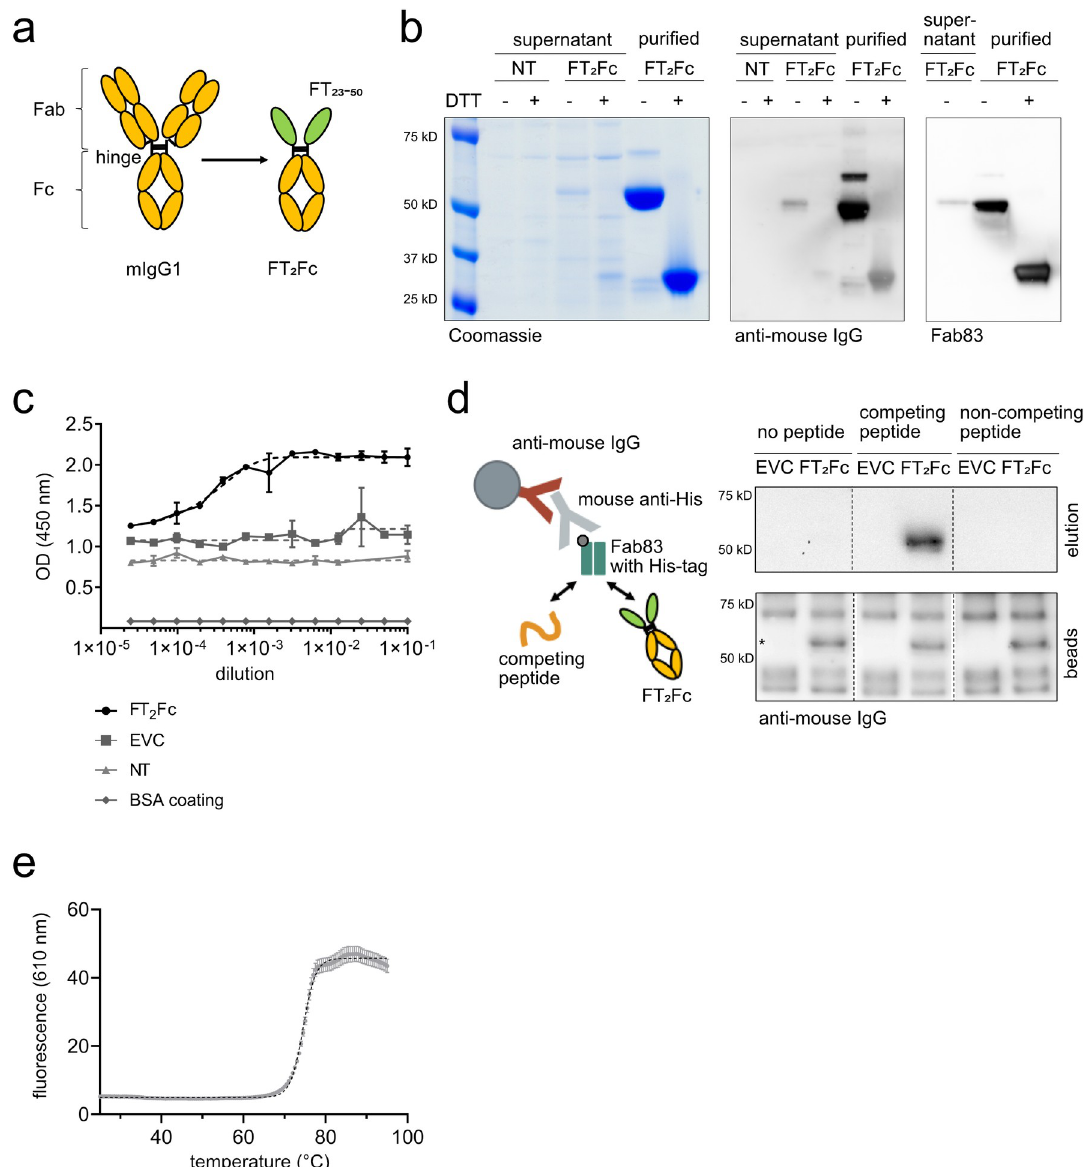
Fig 1. Characterization of FT 2 Fc. (a) Design of FT 2 Fc. FT was fused to mIgG1-Fc at the hinge, thereby replacing the antigen-binding fragment (Fab) and forming a homodimeric Fc-fusion protein. (b) FT 2 Fc was secreted by 293-F cells after transient transfection and was present in the cell culture supernatant as a homodimer with a size of 56 kD. Under reducing conditions (+DTT), FT 2 Fc was present as a monomer. FT 2 Fc was detected in western blotting by antibodies targeting the Fc-fragment and a Fab specific for FT (Fab83). Supernatant from non-transfected cells (NT) was used as negative control. (c) Sandwich ELISA of serially diluted cell culture supernatant from cells transfected with FT 2 Fc showed a sigmoidal curve. The optical-density (OD)—dilution curves were fitted using the four-parameter logistic nonlinear regression model (dashed lines, R 2 = 0.94 for FT 2 Fc). Only background signal was detected in supernatant from cells transfected with the empty vector control (EVC) or non-transfected cells (NT), or when the plate was coated with BSA instead of Fab83. (d) Design of the immunoprecipitation assay (left). Western blots of eluates and beads boiled in sample loading buffer (right). FT 2 Fc was captured in cell culture supernatant by beads coated with Fab83 and was eluted with a peptide specifically competing for the Fab83 binding site, but not with a non-competing peptide. The western blot from the beads confirmed that FT 2 Fc (size of specific bands marked with � ) was bound to the beads in all conditions. (e) In the thermal shift assay, the unfolding of FT 2 Fc with increasing temperature was monitored using a fluorescent dye. The curve was fitted to the Boltzmann equation (dashed line, R 2 = 0.99). The inflection point at 74.5˚C corresponds to the melting temperature of FT 2 Fc in 20 mM sodium phosphate, pH 7.